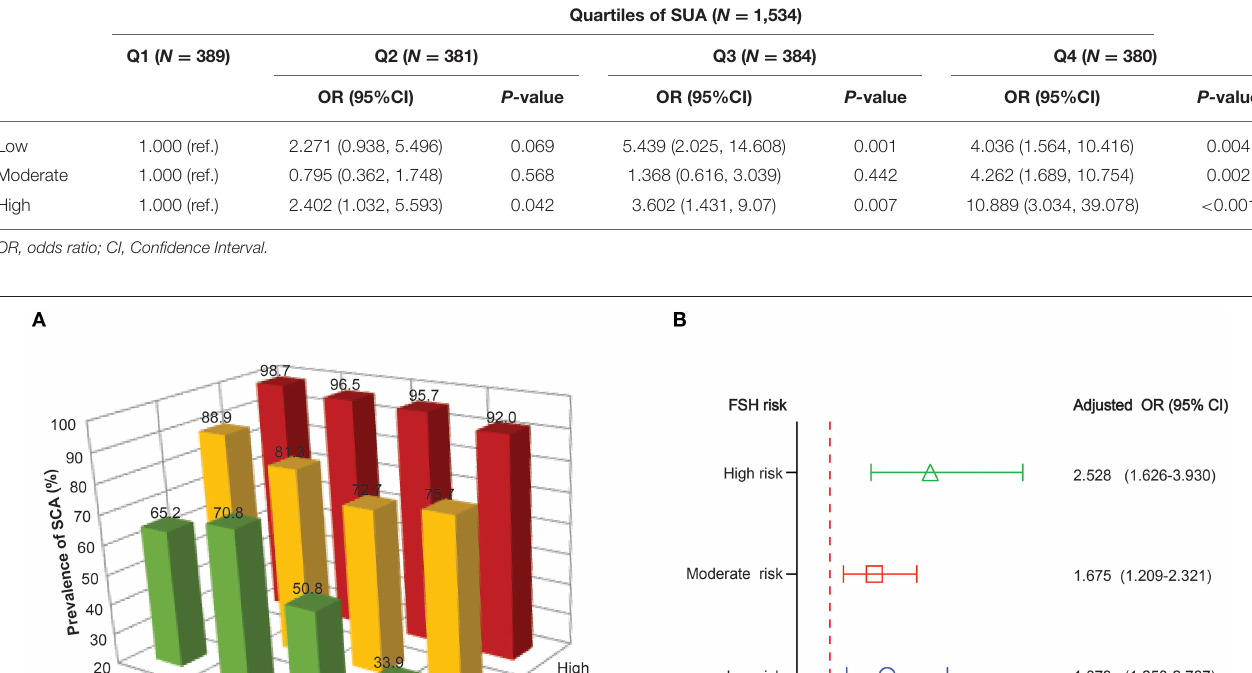
TABLE 4 | Risk of SCA according to baseline serum uric acid quartile in adjusted models in patients grouped by FHS-10 year risk. Quartiles of SUA ( N =